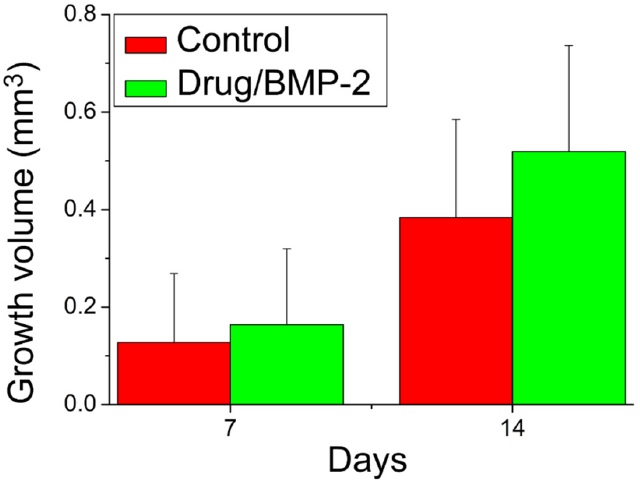
Figure 12. Bone growth in the alveolar bone defect at 7 and 14 days post operation.